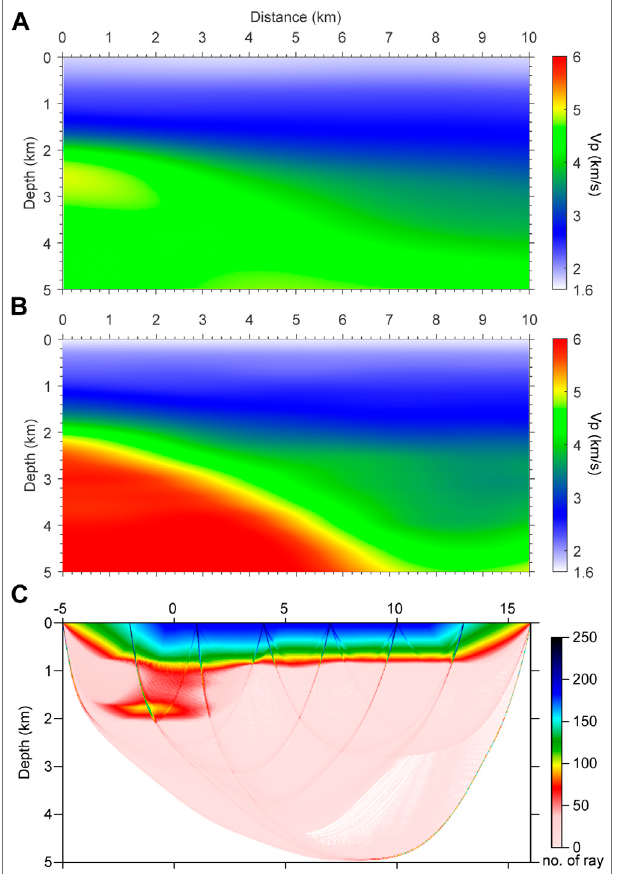
FIGURE 14 | Velocity models: (A) the stacking velocity using re fl ection data from the normal geometry and (B) fi rst-arrival tomographic velocity with Type-II geometry. (C) The ray density map.